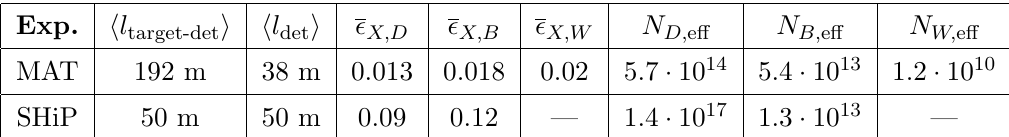
Table 2 . Parameters of the SHiP and MATHUSLA experiments: the average length from the interaction point to the decay volume appendix D for details), values of the overall efficiencies (6.1) averaged over the probed mass range of X for the particles X produced from D and B mesons, the effective number of the D and B mesons and W bosons defined by N larger at SHiP, 7 the effective numbers of B mesons are comparable between the experi- ments, and the average momenta (and therefore the γ factors) of the mesons produced in the direction of the decay volume are caused by (i) different beam configurations (colliding beams for MATHUSLA, fixed target for SHiP) (ii) their different geometric orientation relative to the proton beam direction (the decay volume of the SHiP experiment is located in the forward direction, while the one of MATHUSLA’s is about 20